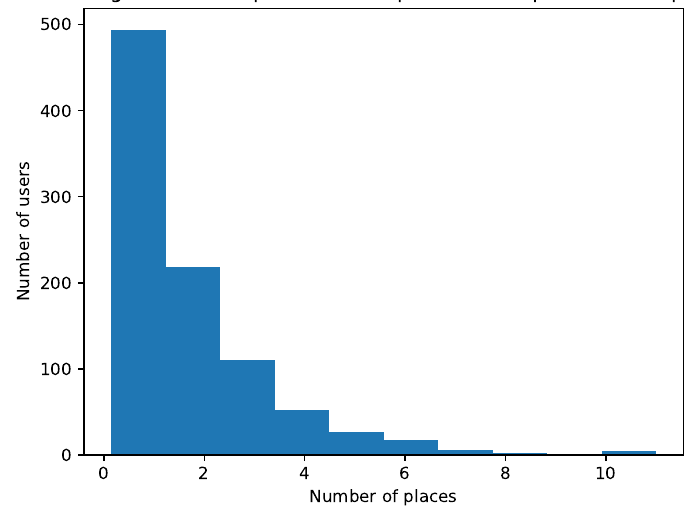
Figure 4. Histogram of the ratio of distinct places visited per travel sequence in